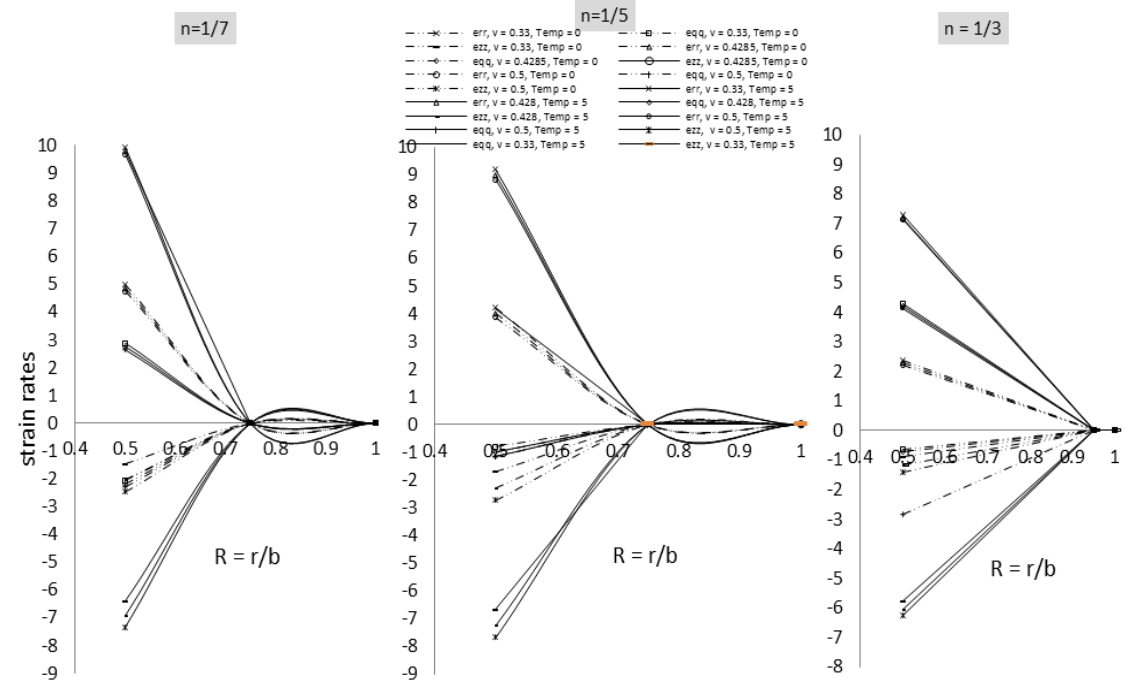
Figure 6(a). Strain rates distribution in disc along the radii ratio R = r/b at angular speed at angular speed 2 5 W = .